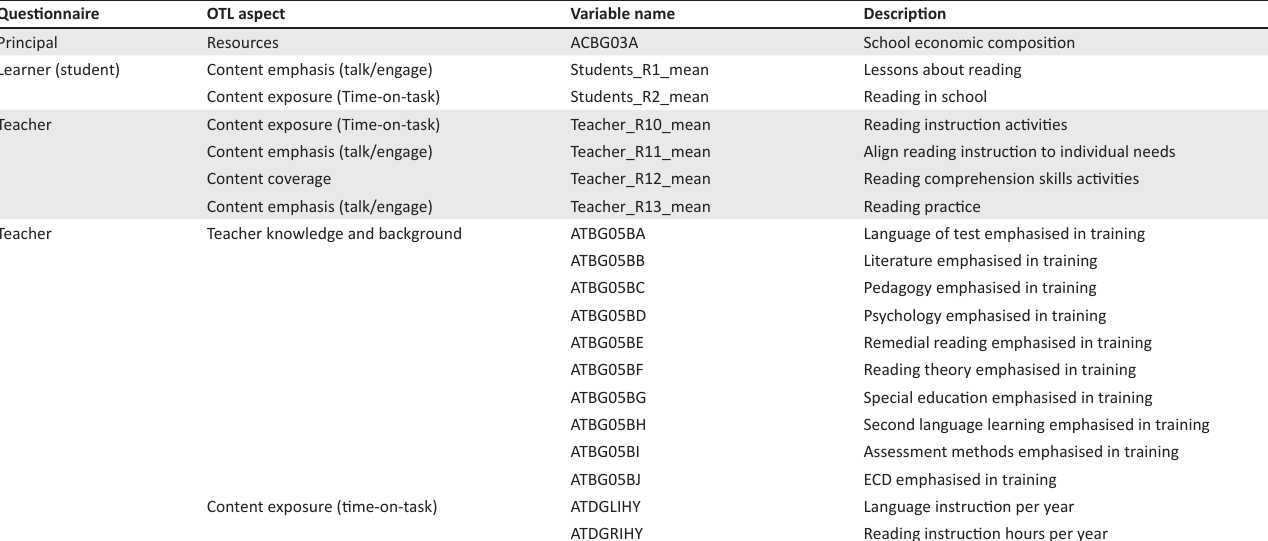
TABLE 3: Selected variables for the current analyses.